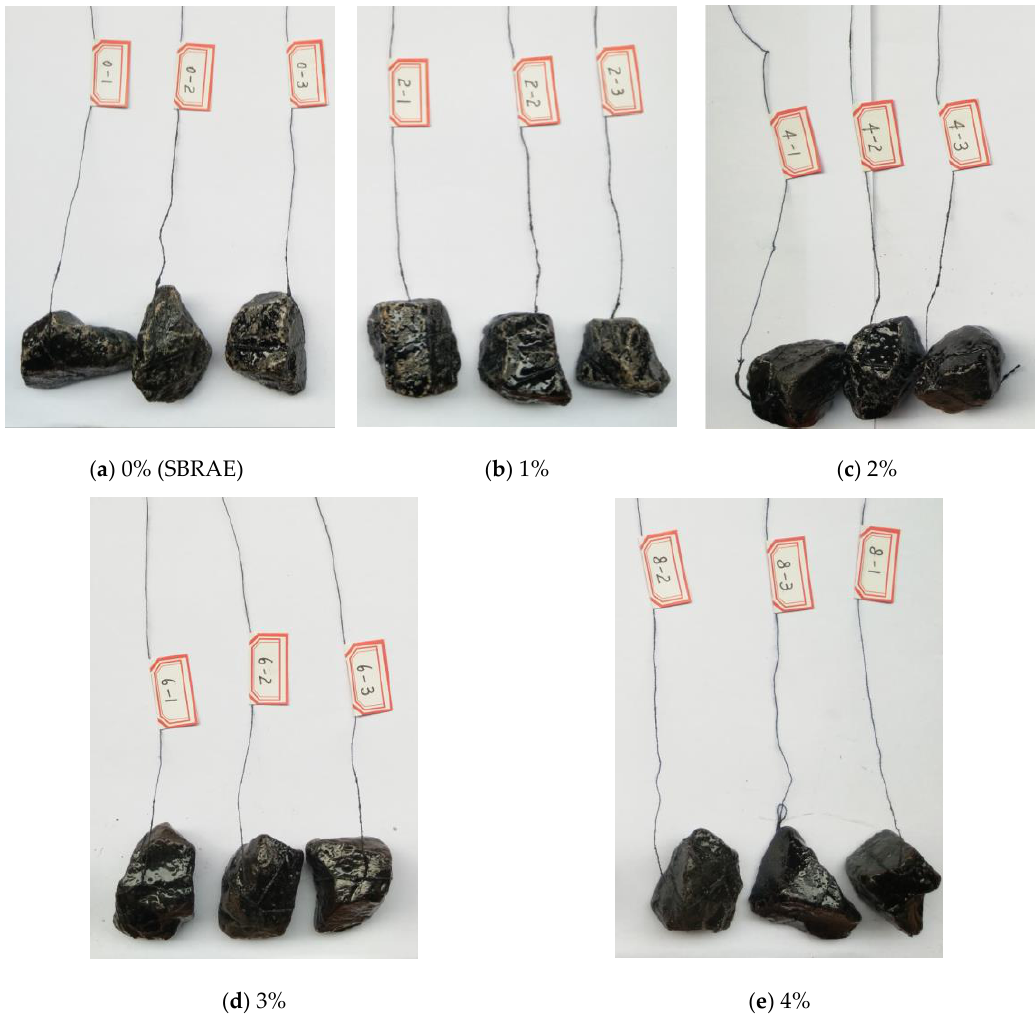
Figure 8. Sample images after the samples were boiled and cooled until dry. Table 5. Test results of the adhesion between the WESAE, SBRAE, and the coarse limestone aggregate.